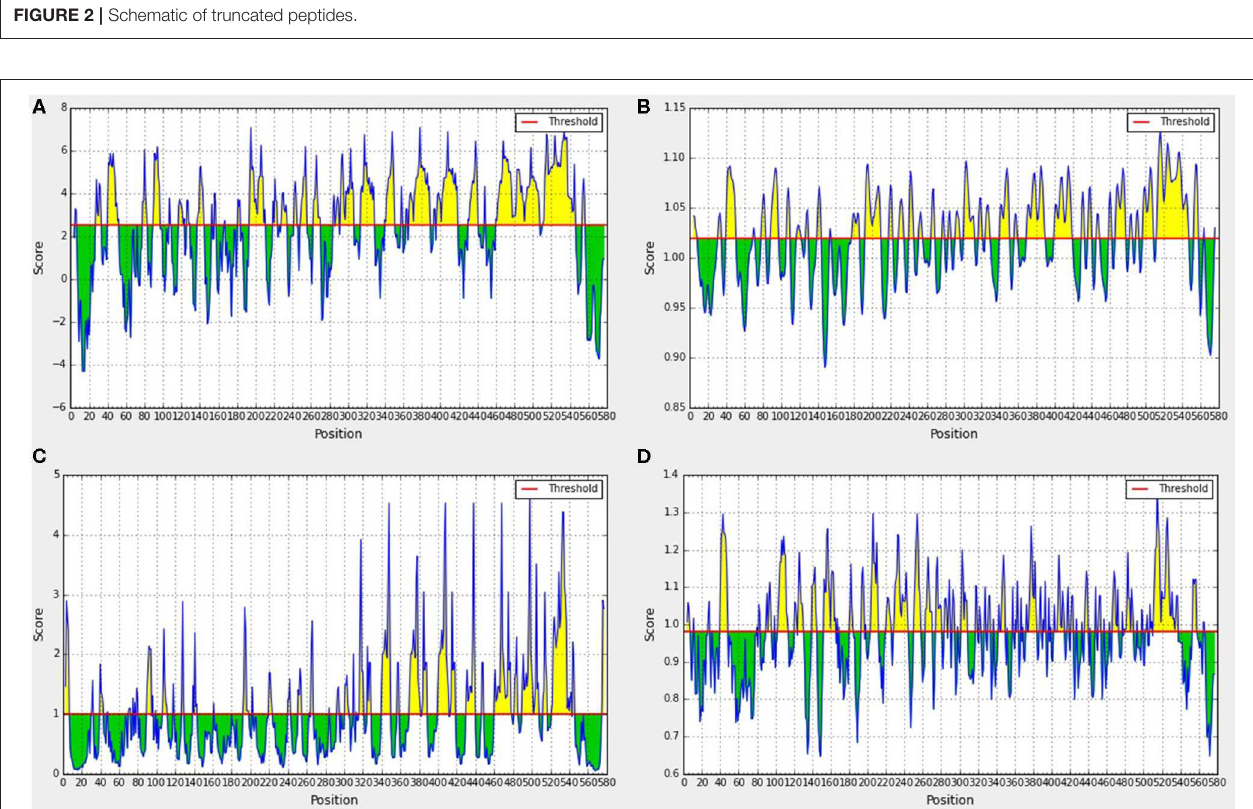
FIGURE 3 | Prediction results of immunoinformatics parameters of Sao-M protein. (A) Hydrophilicity analyses, (B) Flexibility analyses, (C) Surface accessibility analyses, (D) β -sheet analyses.